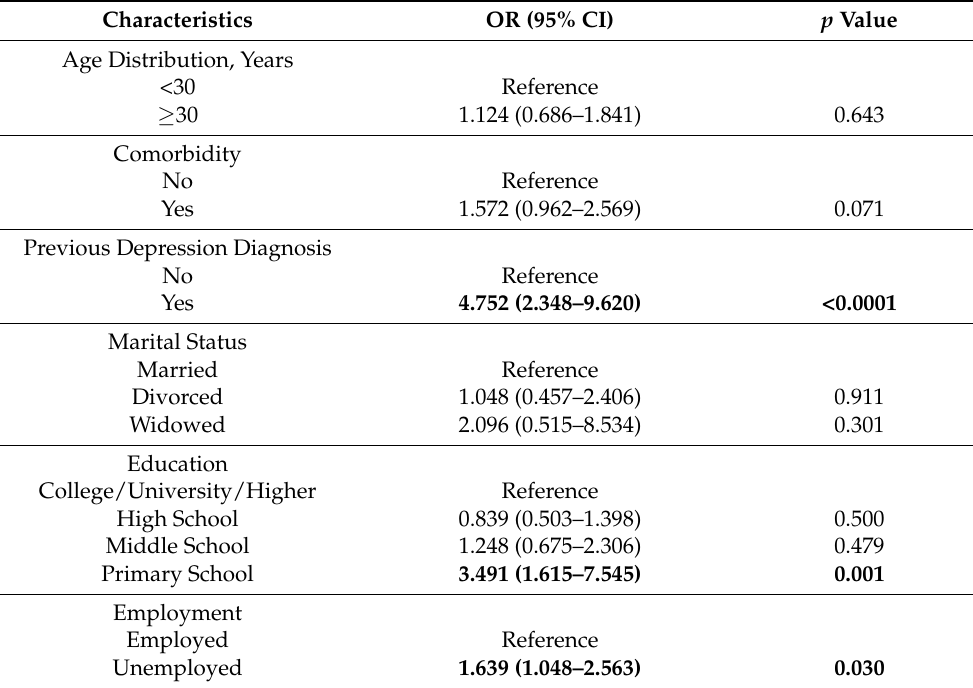
Table 2. Univariate regression analysis of association between sociodemographic, clinical characteris- tics, and